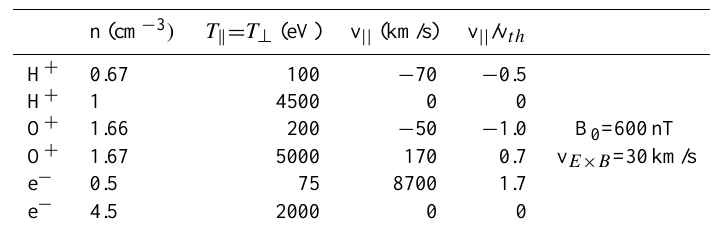
Fig. 8. Energy-time spectrogram of O + observed by the CIS instrument (panel (A) ). We distinguish a cold (200eV) and a hot (5keV) component. Panels (B) and (C) show estimated parallel and perpendicular velocities for the cold O + and the hot O + component, respectively. Table 1. Plasma